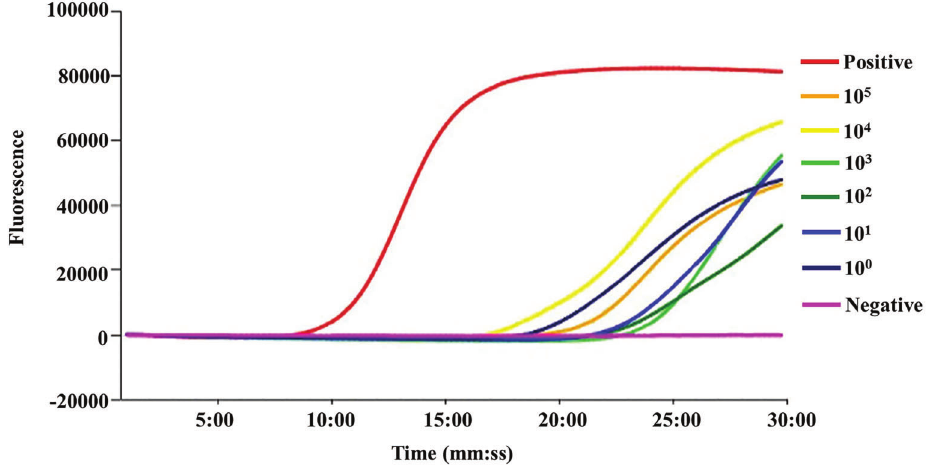
Figure 6. Sensitivity of the loop-mediated isothermal ampli fi cation (LAMP) reactions. The bacterial solutions were serially diluted 10-fold with the mouse blood with a volume ratio of 1:1. These mixtures were lysed and then the suspension was used for the LAMP assay. The positive plasmid was the positive control and water was the negative control. The concentration of bacterium was from 10 5 – 10 0 . All the experiments were repeated twice.